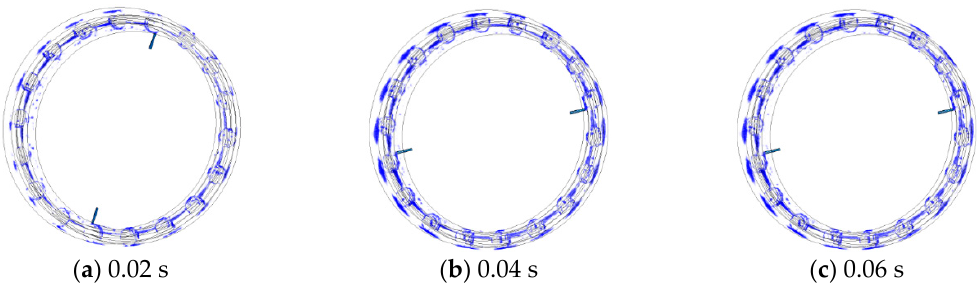
Figure 3. Oil distribution evolution inside the bearing with flow time.